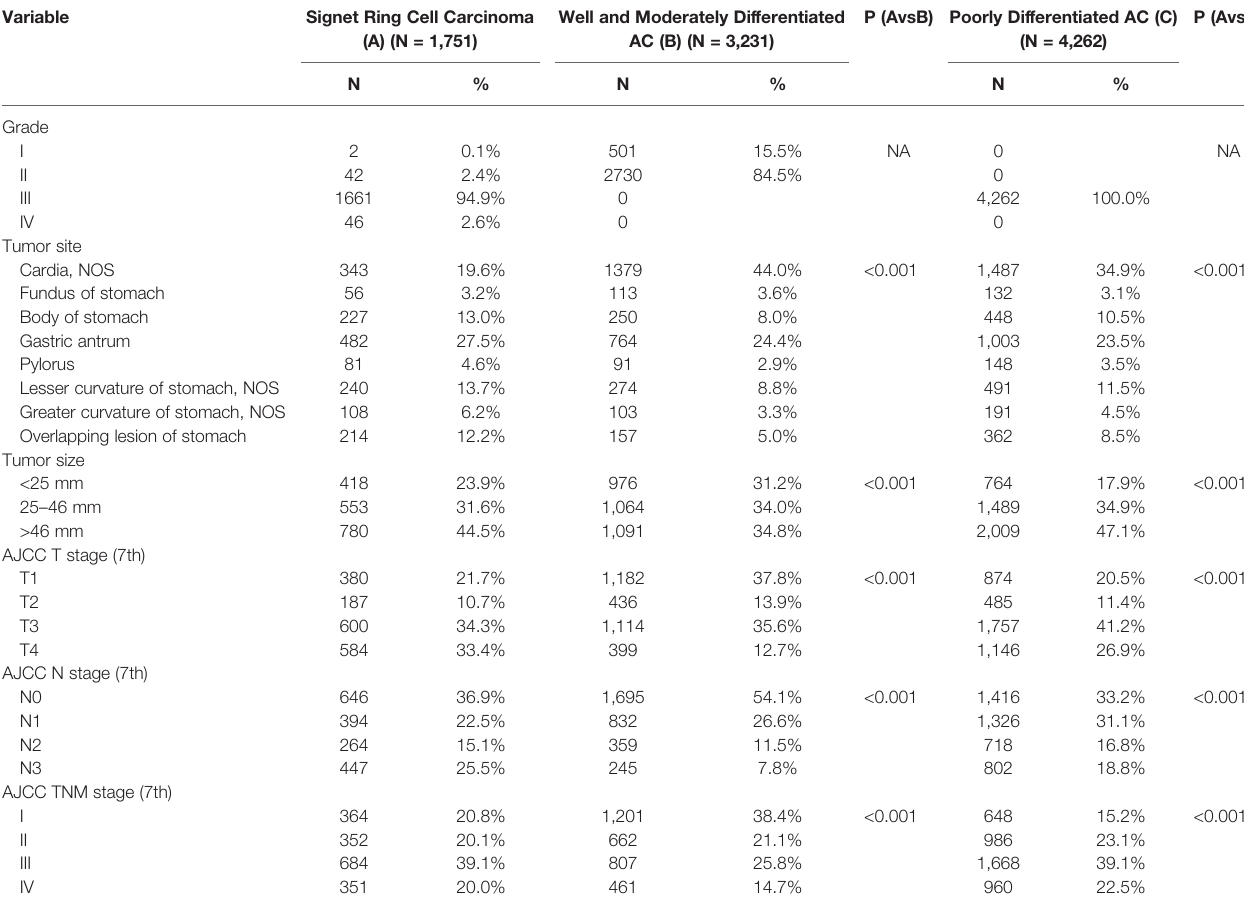
TABLE 2 | Tumor characteristics at presentation.